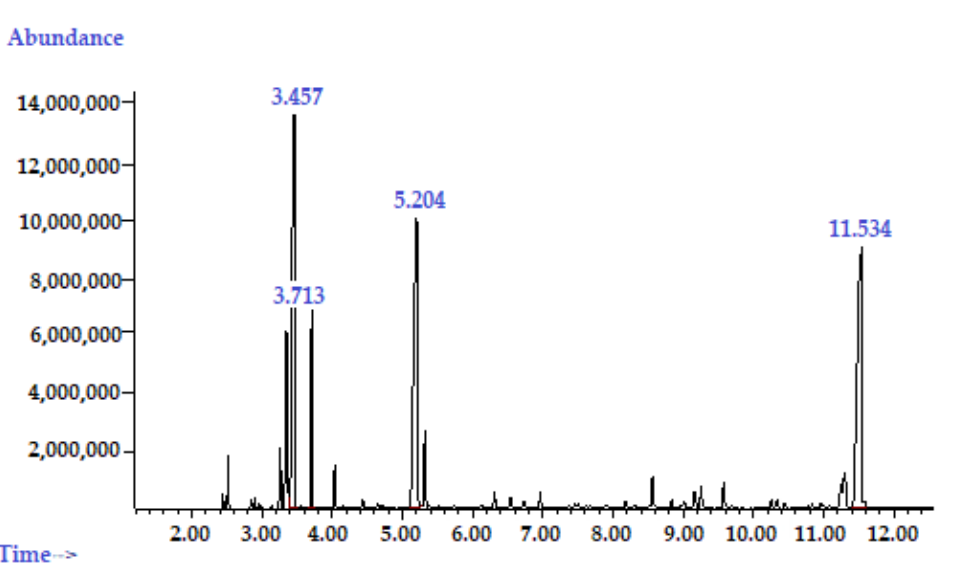
Figure 5. GS/MS chromatogram of the plant-based substance (TTO:1,8-cineole: α -(-)-bisabolol in a 1:1:1 ratio).